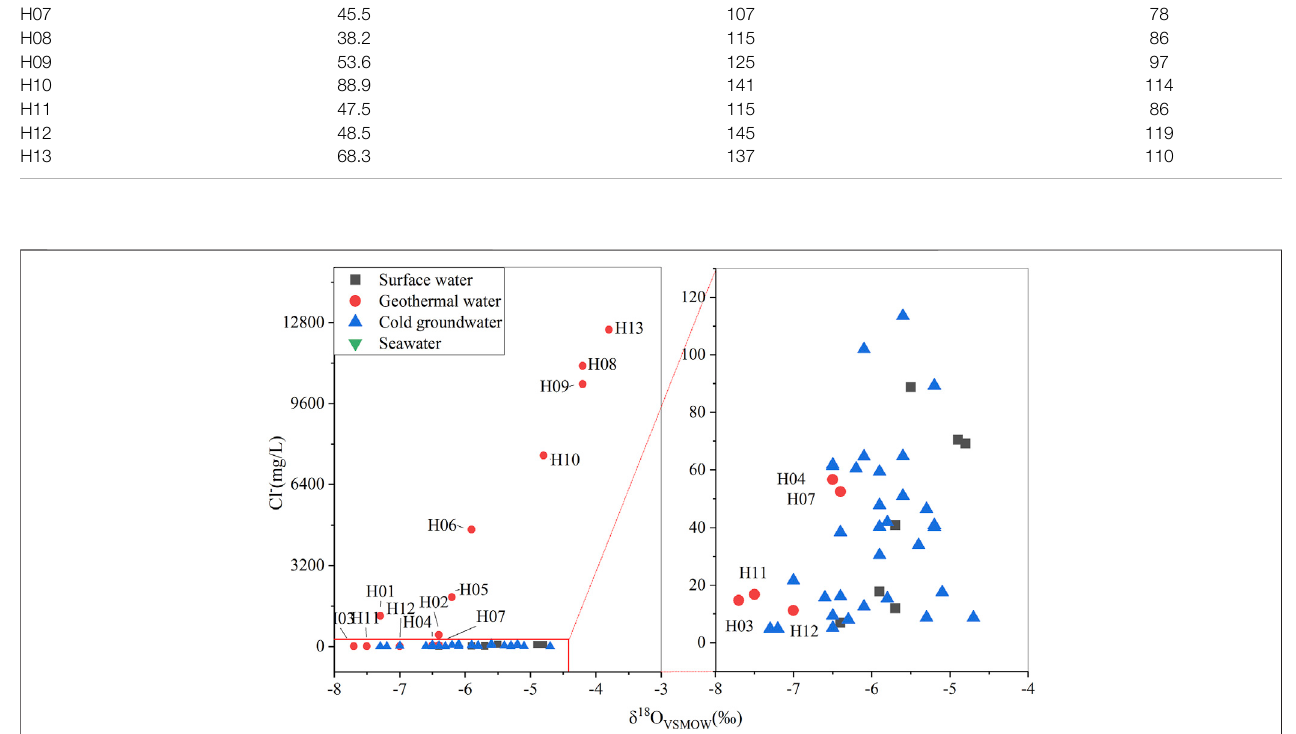
FIGURE 6 | Relationship between the distribution of Cl − concentration and δ 18